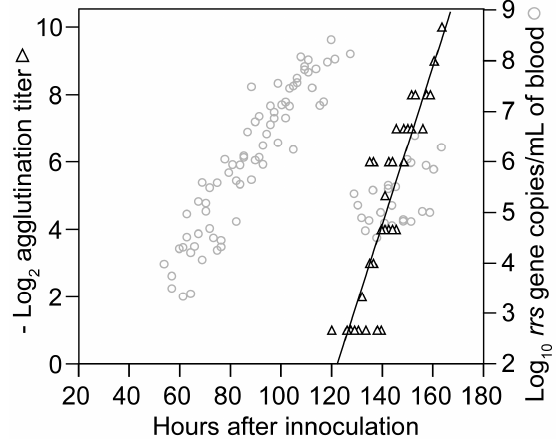
Figure 6. Rise in agglutinating antibodies to B. hermsii during infection. The graph superimposes a scatter plot of log-transformed reciprocal titers of antibody to serotype 7 of B. hermsii by a macro-agglutination assay (black triangles) on to the values for B. hermsii growth in the blood (gray circles) of Figure 3. The samples were drawn from the same group of mice described for Figures 3 and 4 (Section 3.1.2). Each data point is a sampling from a single mouse.